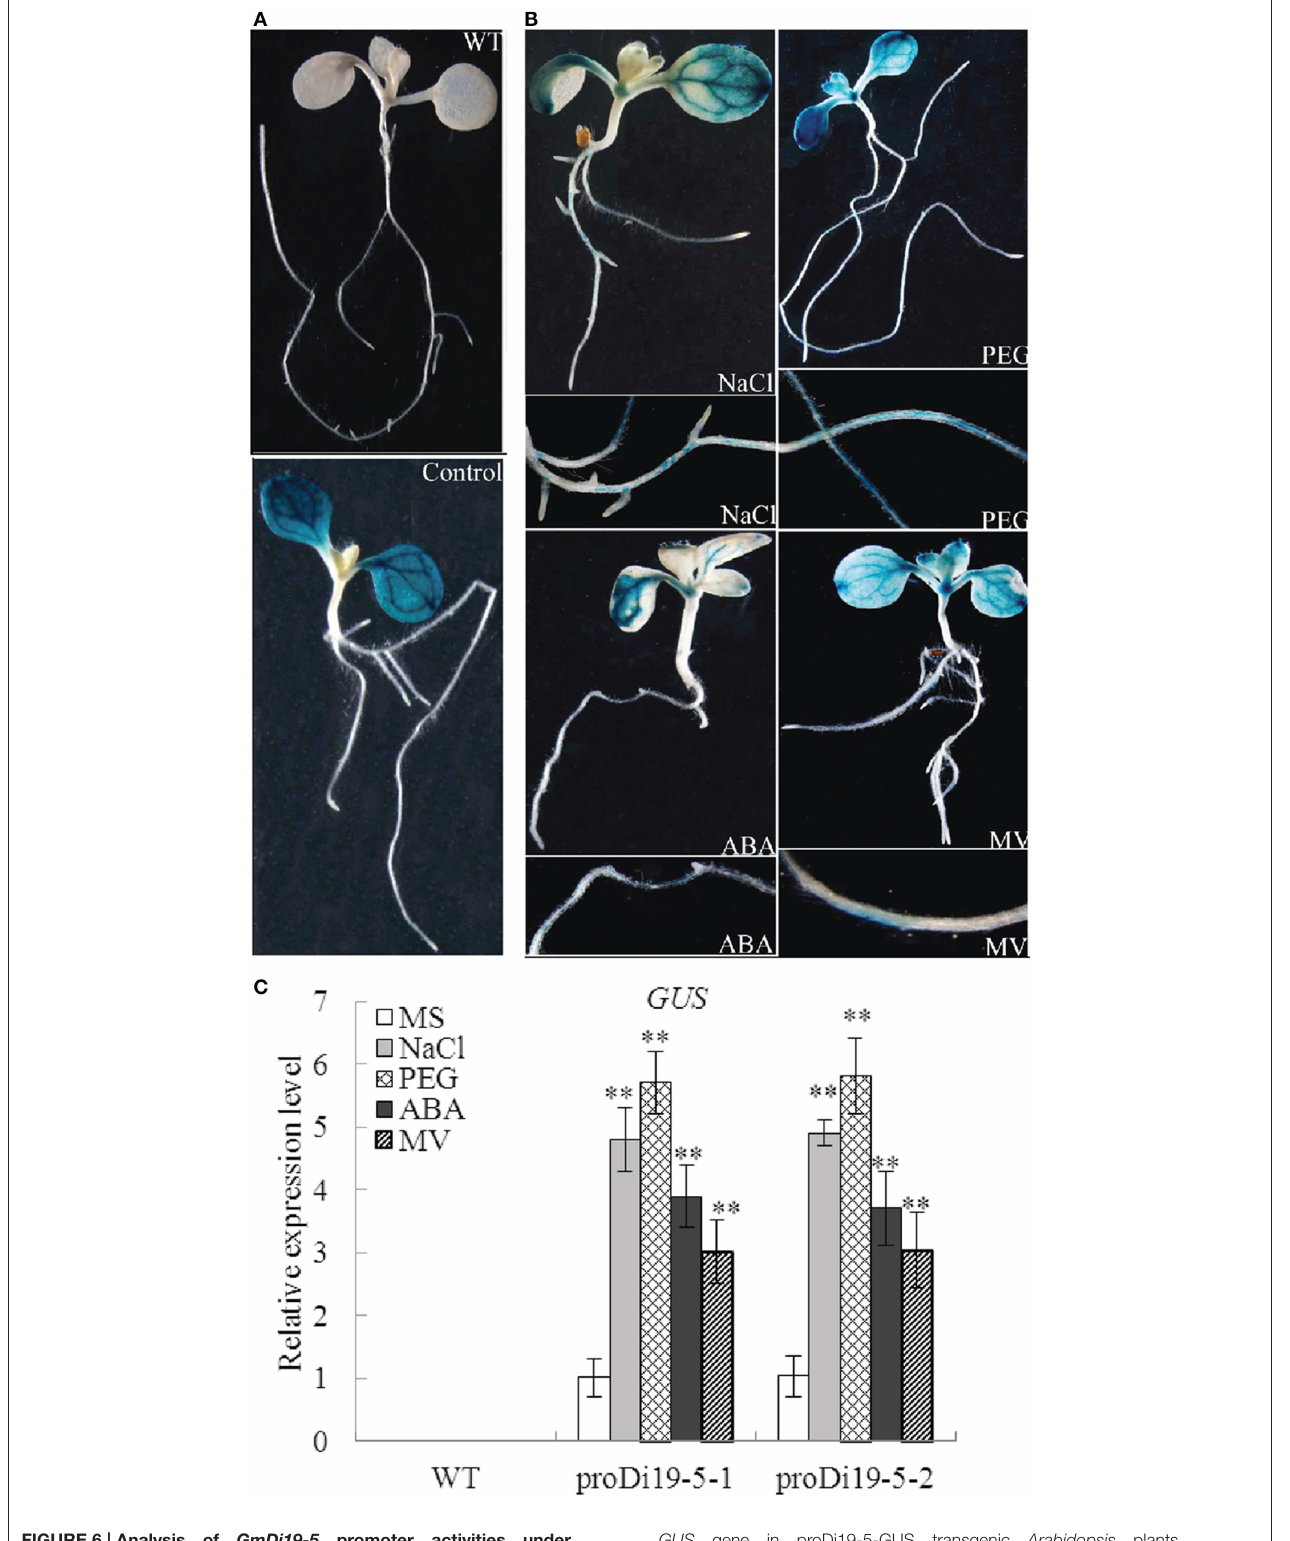
FIGURE 6 | Analysis of GmDi19-5 promoter activities under abiotic treatments. (A) 10-d-old seedlings of WT and transgenic plants. (B) Transgenic seedlings treated with NaCl, PEG, ABA, and MV. (C) qRT-PCR analysis of expression of